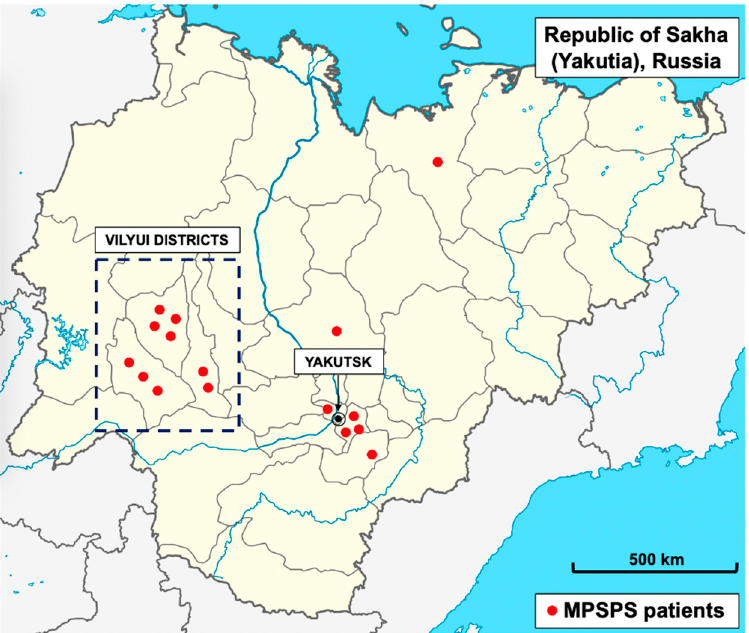
Figure 2. Distribution of MPSPS patients in Yakutia. Red rounds indicate MPSPS patients. Most patients were found in the Vilyui group of districts (blue dotted rectangle) and near city of Yakutsk (circled dot), the capital of Yakutia (North-Eastern Siberia, Russia).